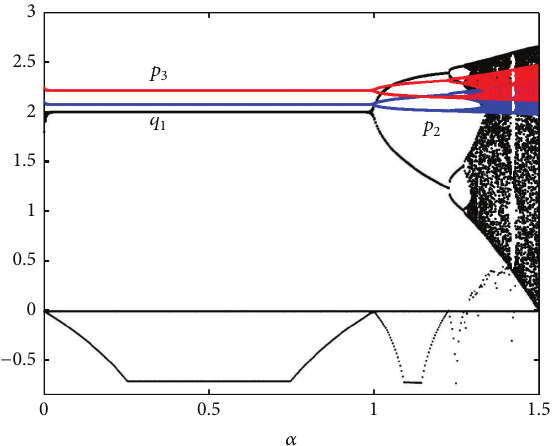
Figure 2: Bifurcation diagram and the Largest Lyapunov exponent of the discrete dynamic system (7) for 𝛽 = 0.15 , 𝛾 = 0.2 , and 𝛼 varying from 0 to 1.5.